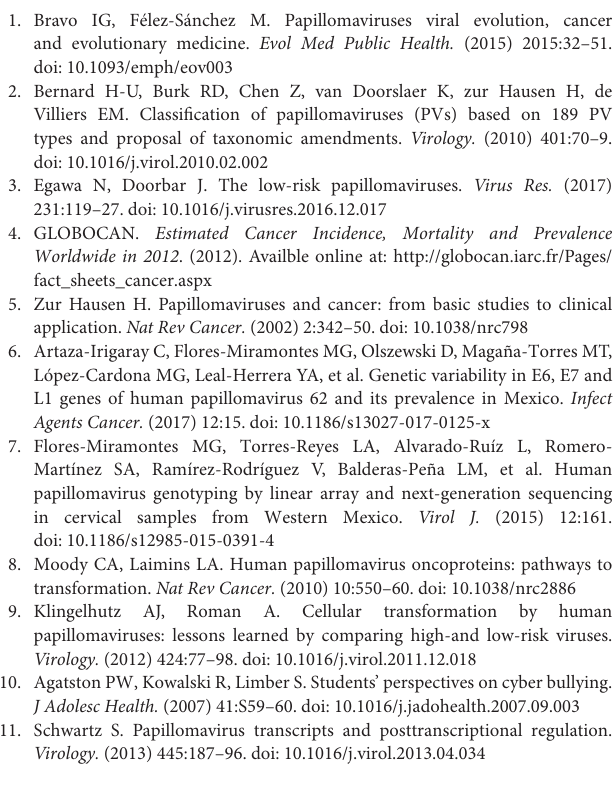
Table S1 | Primers and experimental conditions used for PCR amplifications. Figure S1 | p53 and IL-6 expression in E6 transduced HaCaT cells compared to HaCaT-pLVX control cells, after p53 wt transfection. (A) p53 mRNA relative